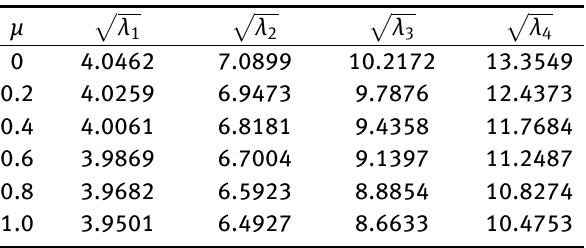
Table 13: Frequency parameter cal